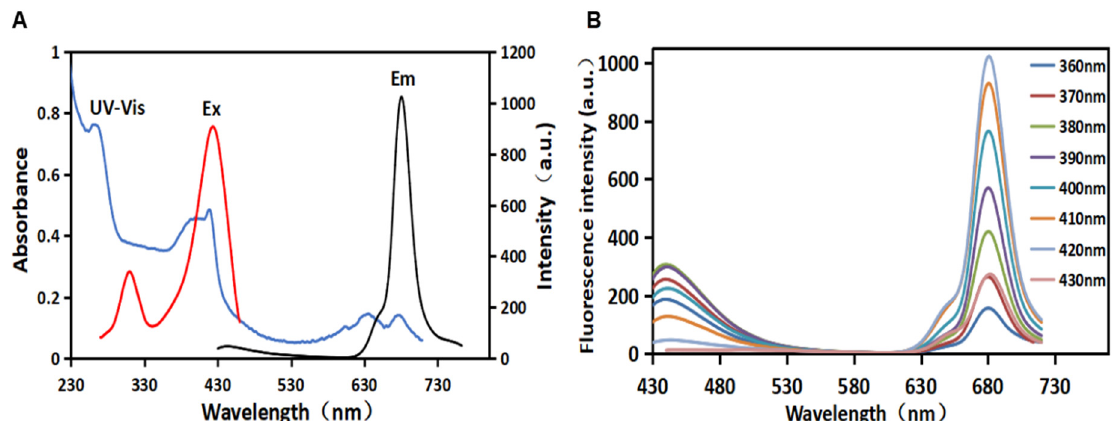
Figure 1. UV–visible absorption spectrum (blue), excitation spectrum (red), and emission spectrum (black) of R ‐ CDs ( A ); fluorescence emission spectra of R ‐ CDs ( B ).